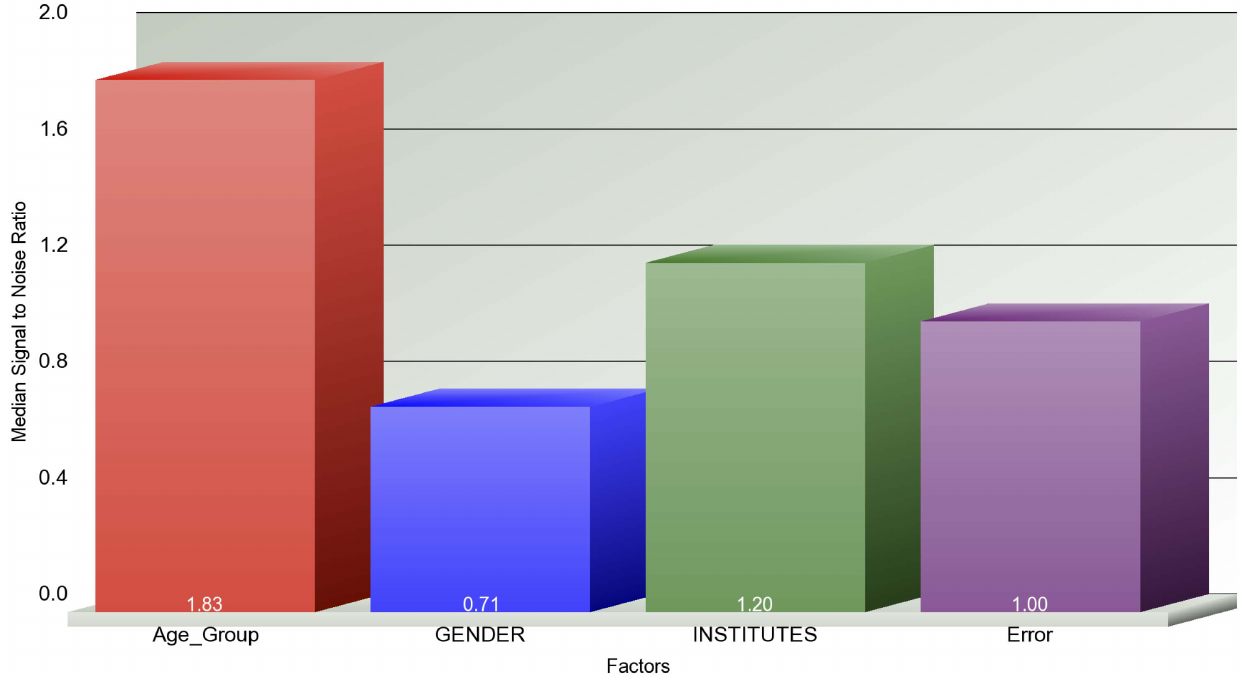
Figure 5. Source of variation of expression profiles of age-specific genes in the REMBRANDT data set. The x-axis shows the components of the 3-way ANOVA model and the y-axis shows the median signal to noise ratio. The ANOVA model is built based on the expression profiles of the TCGA age-specific genes in REMBRANDT data set. The TCGA age-specific genes are the intersection of DEGs computed on TCGA Affymetrix U133A and Agilent G4502A data sets.